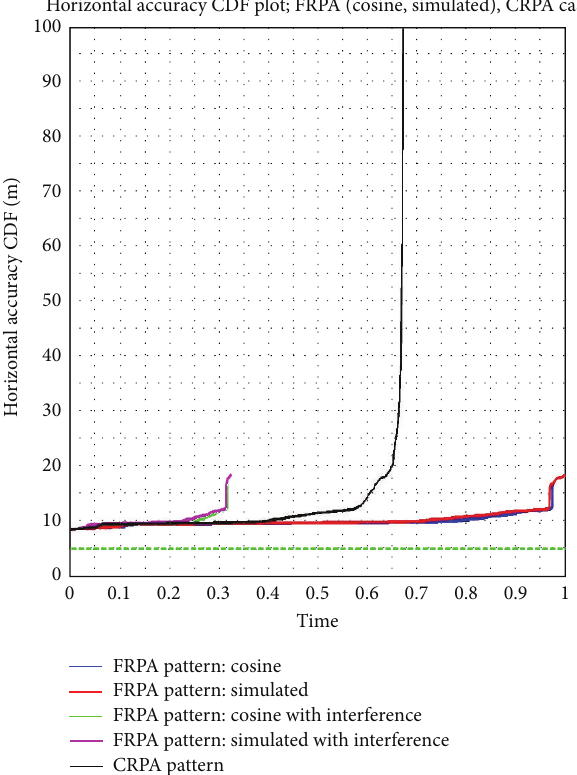
Figure 19: Horizontal accuracy CDF curve − 24/24GPS constella- tion and 3RF interfering satellites.